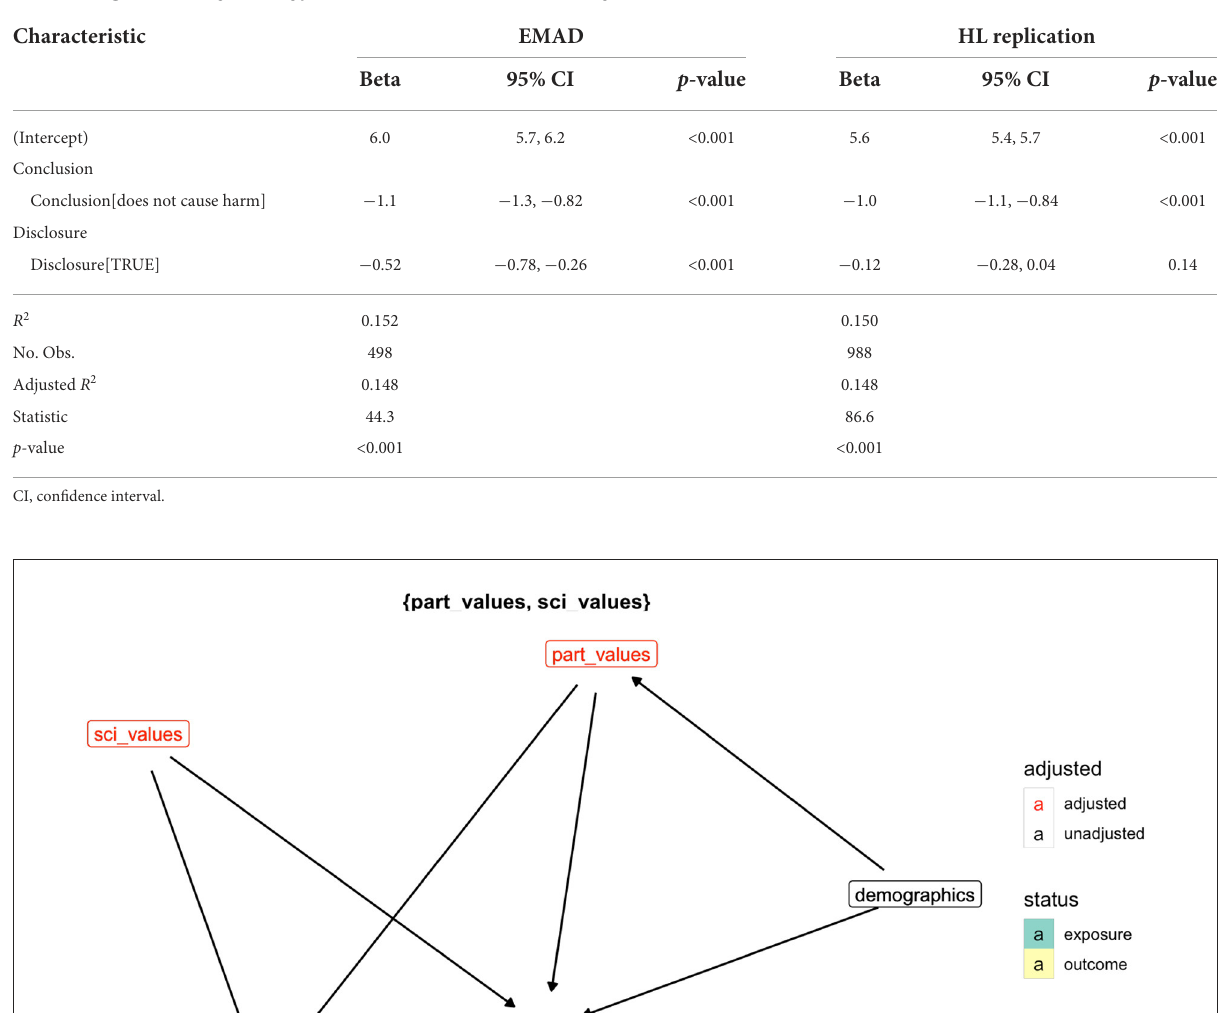
TABLE 2 Regression analysis for hypotheses H2 (consumer risk sensitivity) and H3 (disclosure effect).